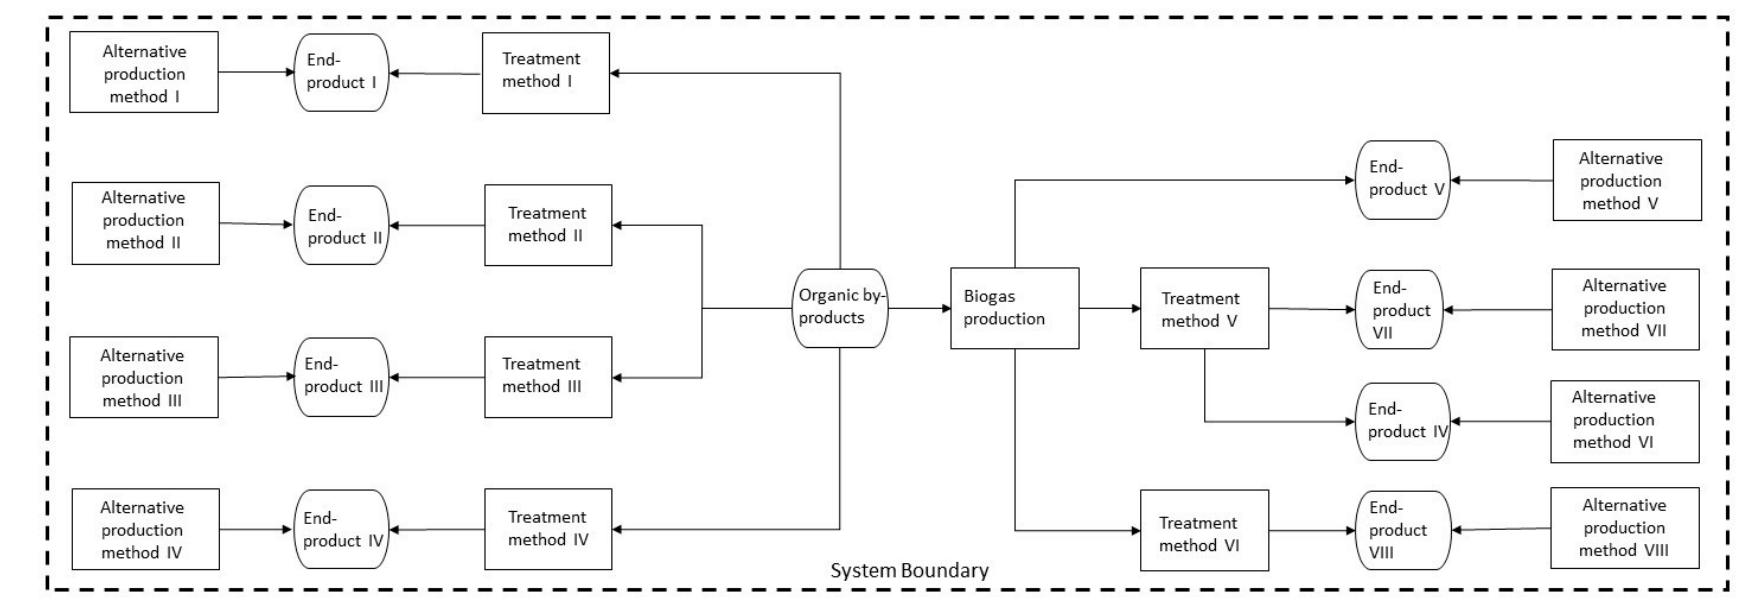
Figure 2. The system studied including the system expansions (the alternative productions methods). The dotted line shows the system boundary.